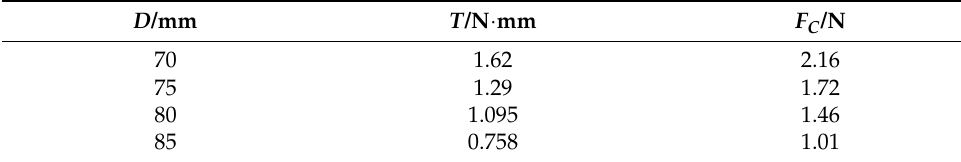
Table 1. T and F C at different D from measurement.